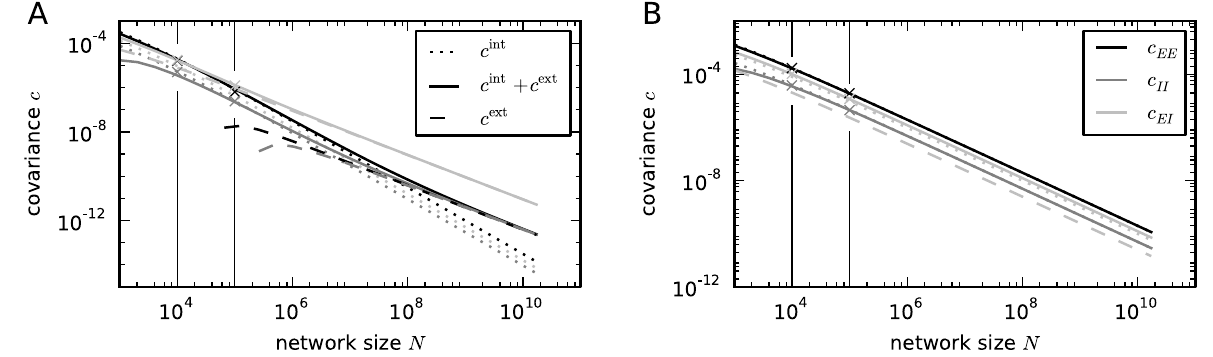
a a ~ r ext : { d ! N { 1 (38) and [24, eqs. (38)–(39)] driven by external ab ab ab N a a a z r intr : { d . The relative error at 100,000 ab ab ab N a ^ 0 , so the only dashed curve aa